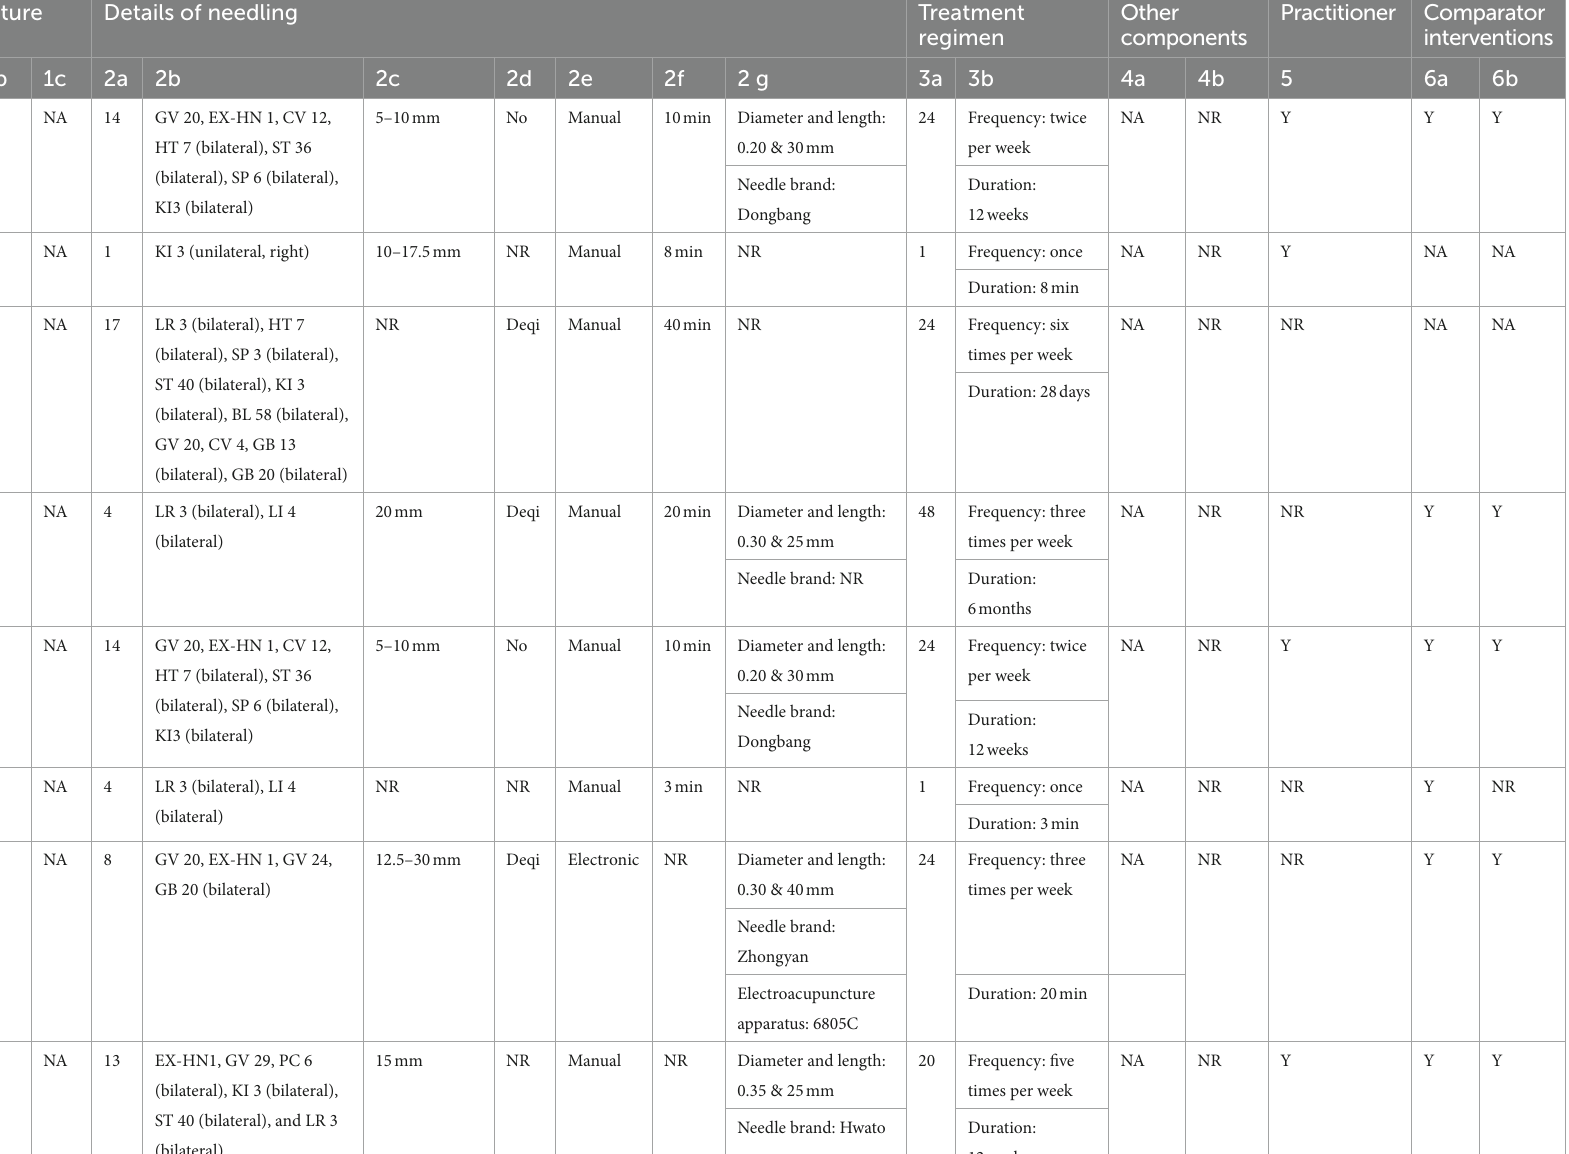
Needle brand: Hwato